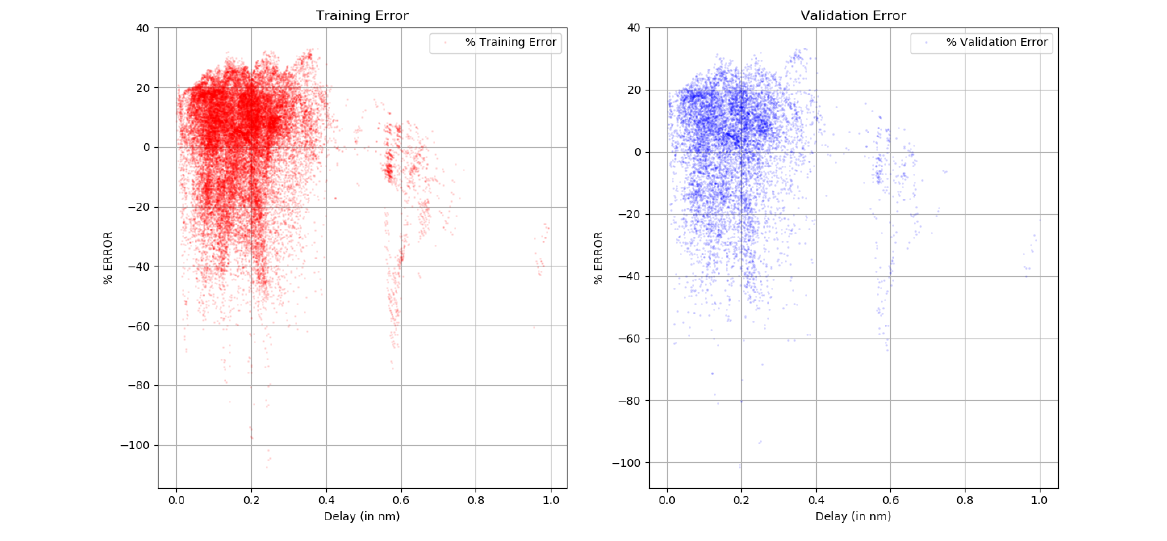
Figure 23. Error analysis of training data and test dataset.